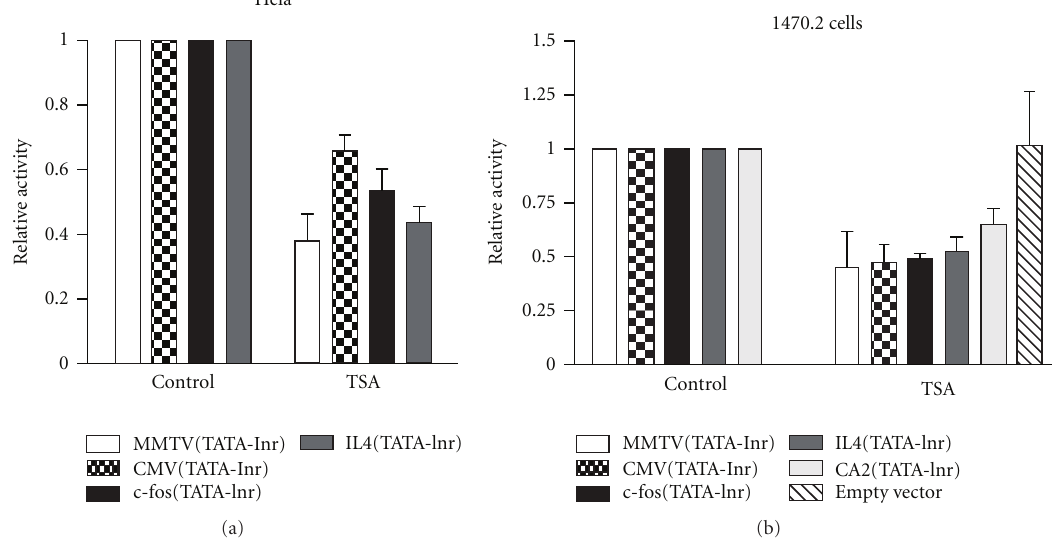
Figure 2: Transcription dependent on core promoters is repressed by TSA. Luciferase reporter constructs were generated which contain core promoters (TATA to Inr sequences) from several viral and cellular genes, including Cytomegalovirus (CMV), c-fos, interleukin 4 (IL4), and carbonic anhydrase II (CA2). These constructs were transiently transfected into either Hela or 1470.2 cells which were treated with or without TSA (50ng/ml) for 6h. Cell lysates were assayed for luciferase activity, and the data was processed as described in the legend to Figure 1. Results from at least 3 independent experiments done with Hela or 1470.2 cells are shown. Error bars represent SEM.